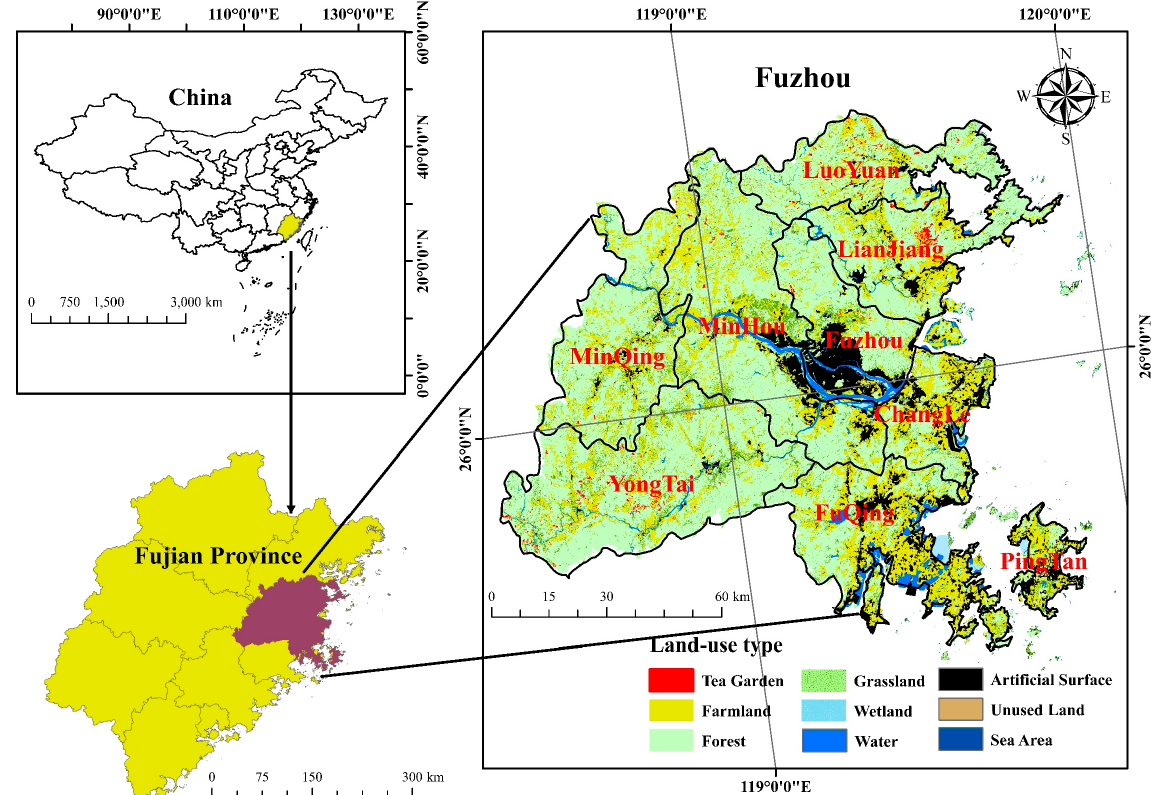
Figure 1. Schematic diagram of the study